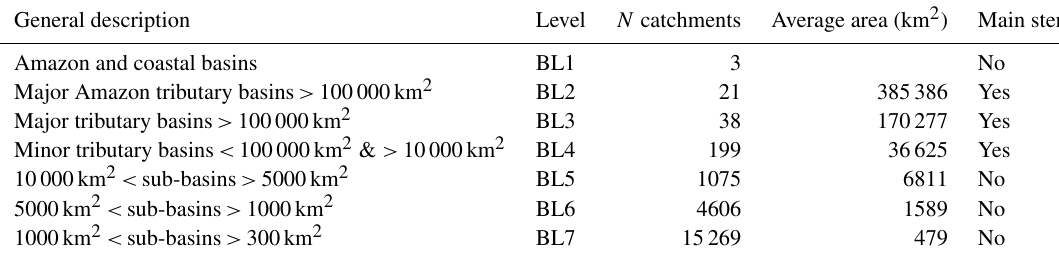
Table 2. General description of catchments system for Amazon